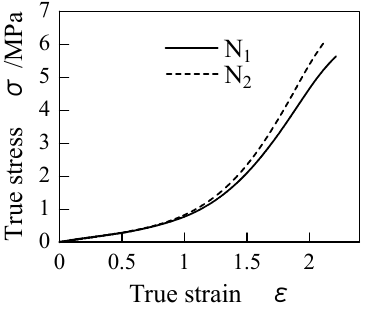
Figure 3. Stress-strain curve of rubber.